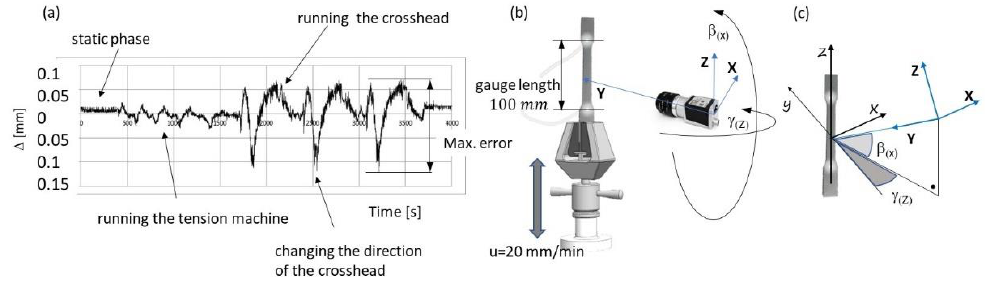
Figure 10. Accuracy measurement, ( a ) measurement results for different conditions, ( b ) measuring system with calibration, and ( c ) system transformation characteristics.